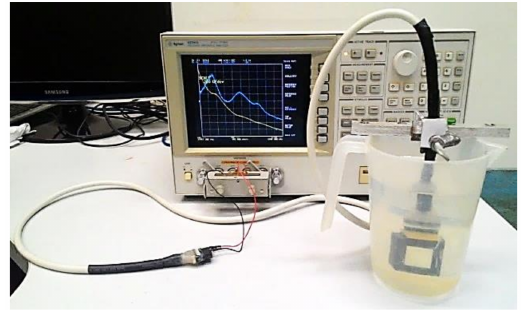
Figure 10. Electrical impedance measurements, |Z| ( Ω ) in yellow and phase ( o ) in blue was carried out with an impedance analyzer, with the transducer immersed in water, to taking into account the acoustic load of the medium of operation.